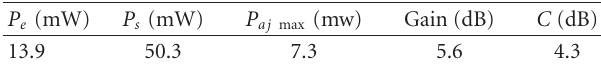
Table 3: Simulated oscillator preformances.